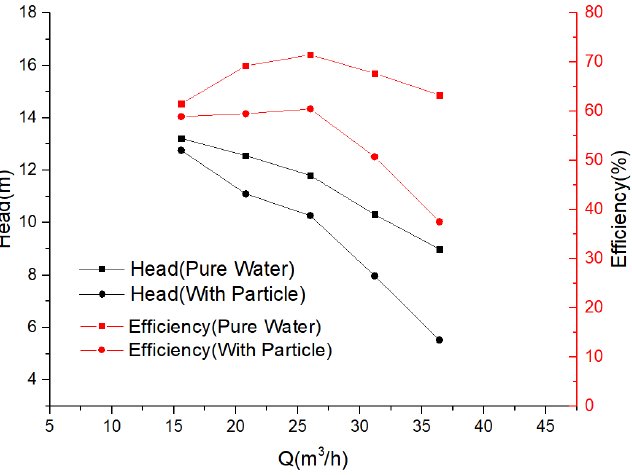
Figure 14. Pump head efficiency under different volume flow rates ( d p = 0.6 mm, C V = 5%).